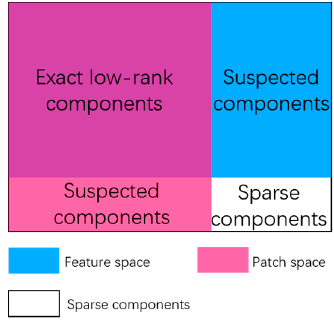
Figure 1. Explanation of our motivation to integrate patch space with feature space.